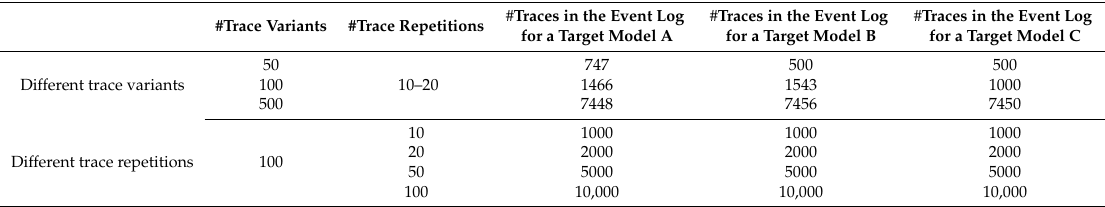
Table 7. Different log settings for three universities.